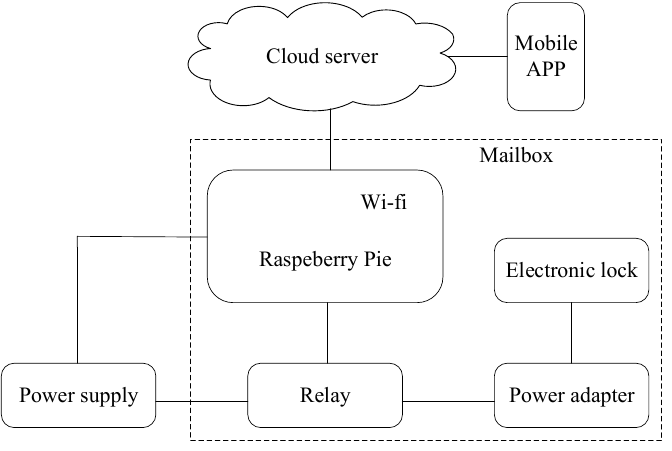
Figure 19. A schematic diagram of the mailbox.